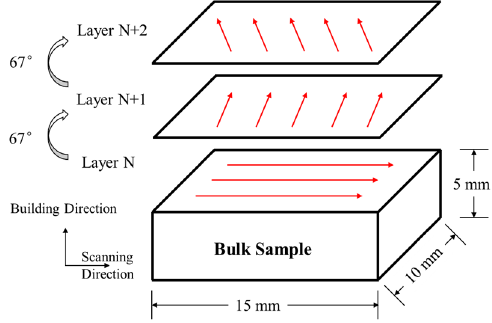
Figure 2. Schematic diagram of additive manufactured preparation process.